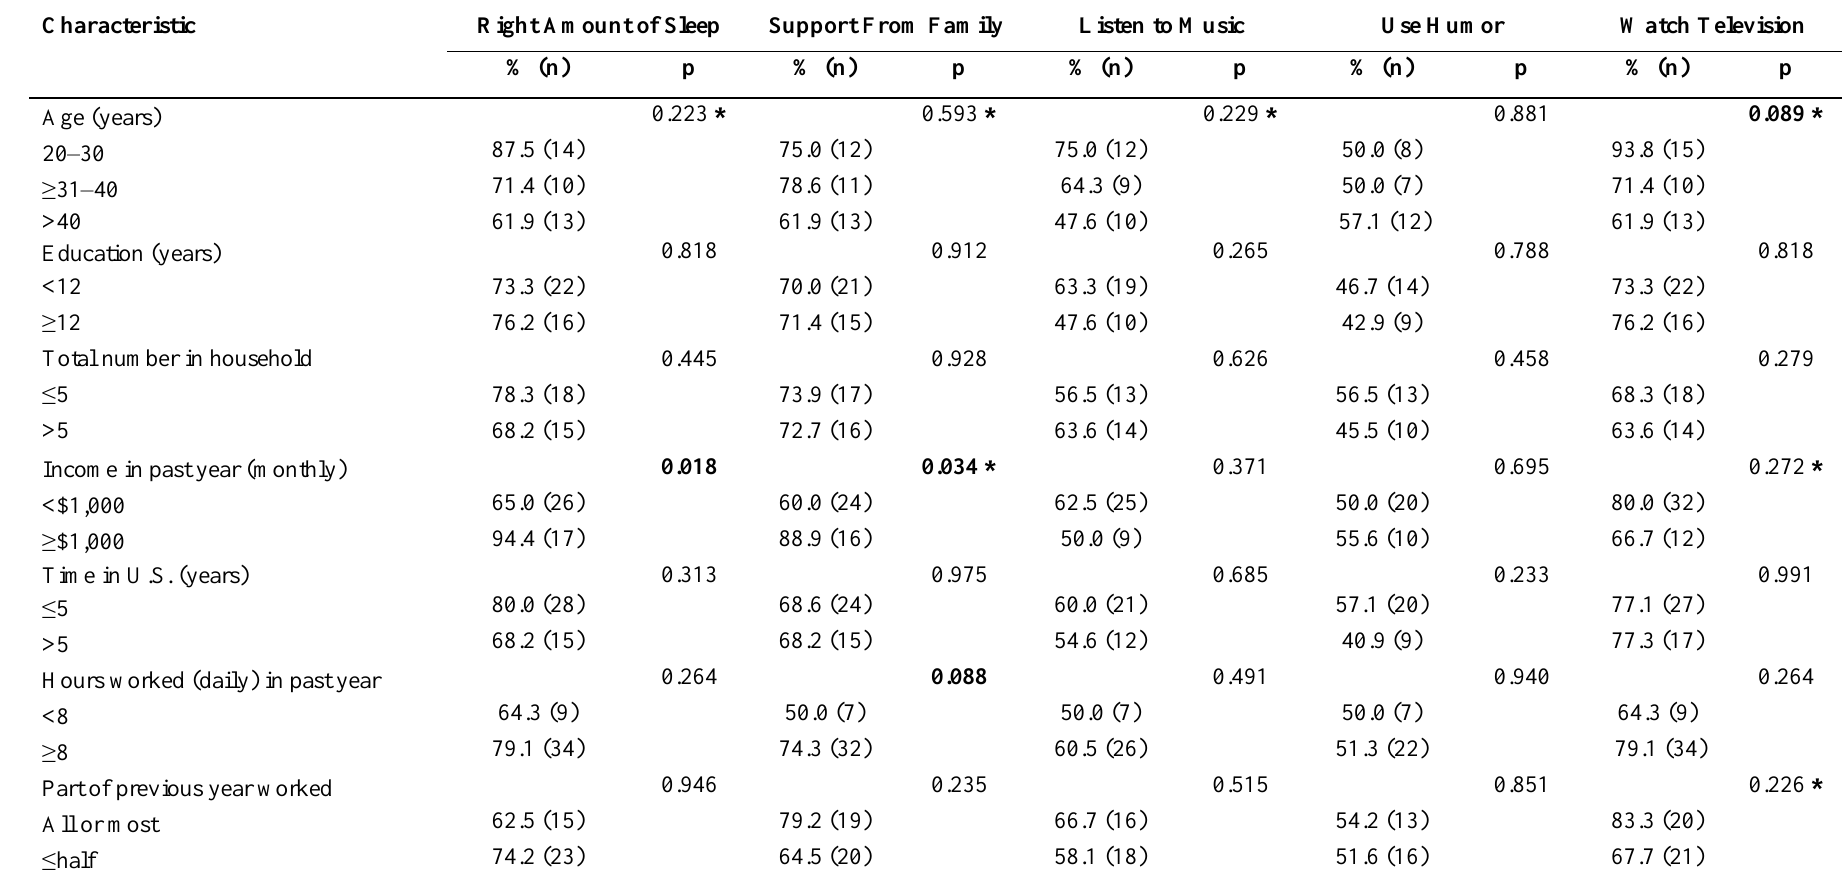
Table 3. Top 5 stress coping behaviors and demographic and work